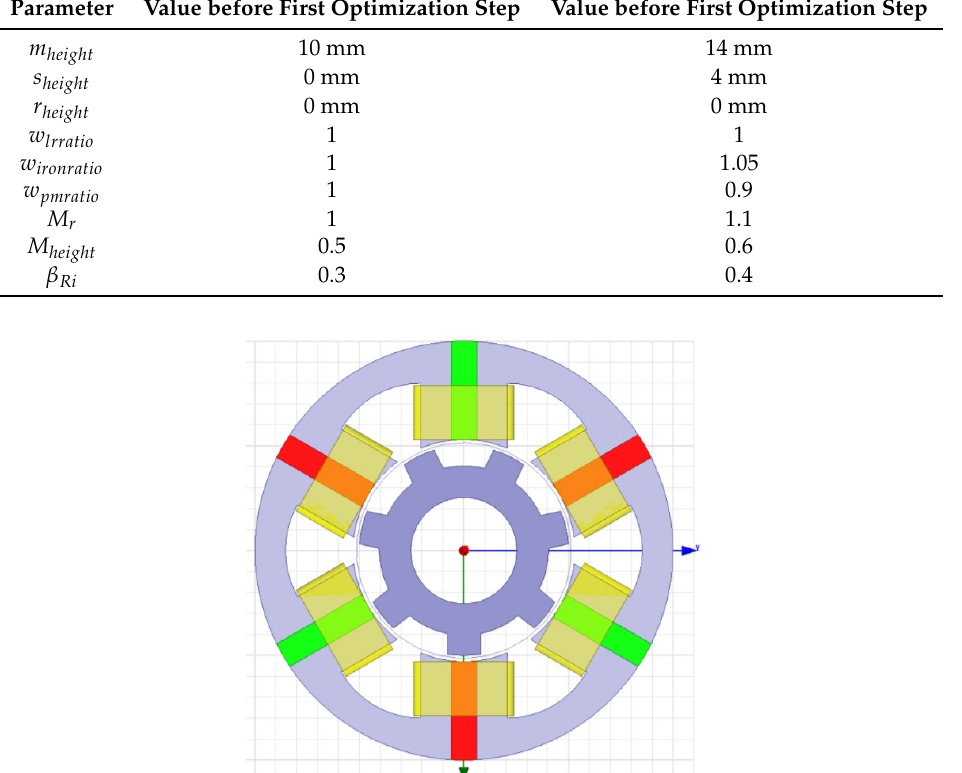
Table 14. Geometric parameters of the FSPM after the optimization.